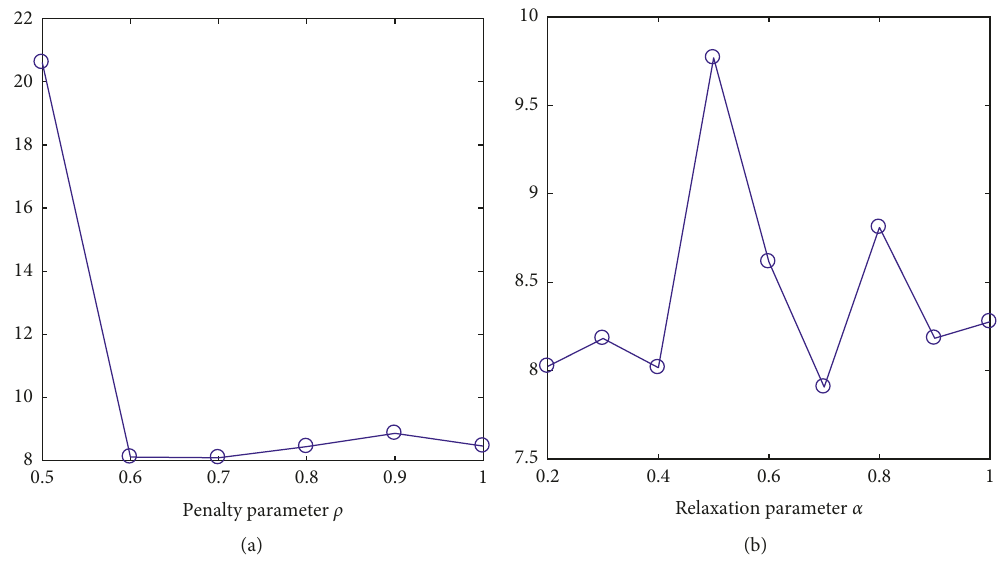
Figure 1: Effect of penalty parameter ρ of ADMM (a) and relaxation parameter α of r-ADMM (b) in terms of average number of iterations taken to converge. For each setting, algorithms are performed 50 times on the UAV control task ( N � 10) with random initial states.